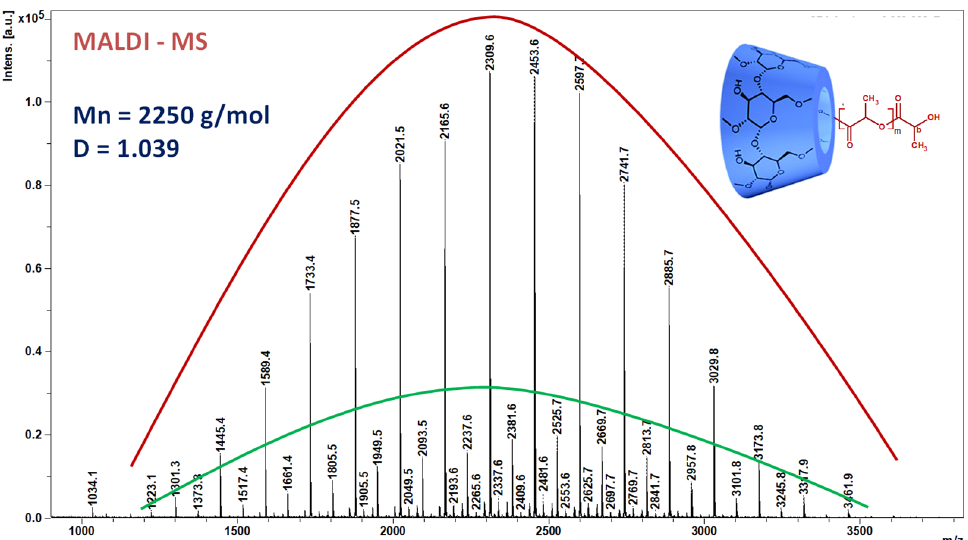
Figure 1. The MALDI MS spectrum of CDLA derivatives: the red line indicates the main series of peaks with an even number of lactate units and the green line indicates the secondary series of peaks with an odd number of lactate